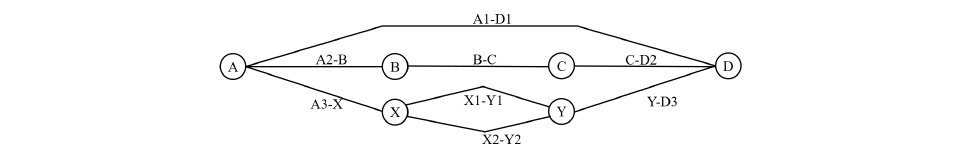
Figure 2. A Complex, Hybrid Multi-Channel, Multi-hop